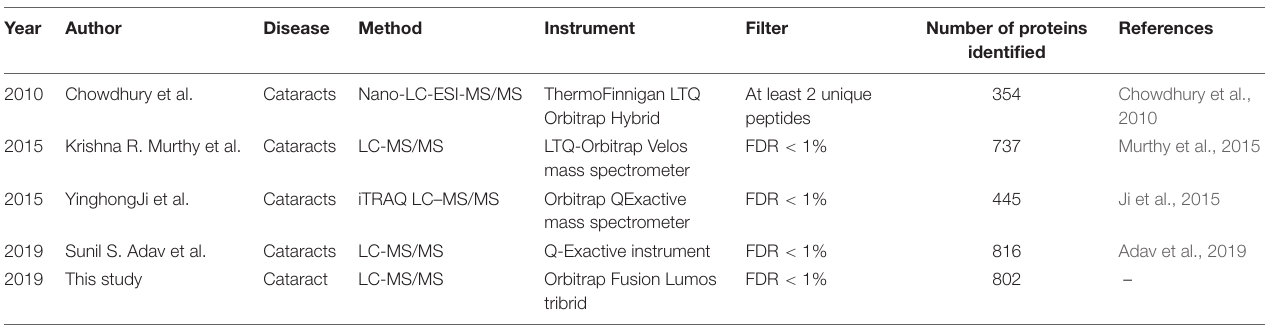
FIGURE 1 | Workflow of the human aqueous humor (AH) fluid proteome profile analysis and the discovery/validation of differently expressed proteins (DEPs) in the neovascular glaucoma (NVG) treatment. TABLE 1 | Comparison of 5 aqueous humor (AH) proteome